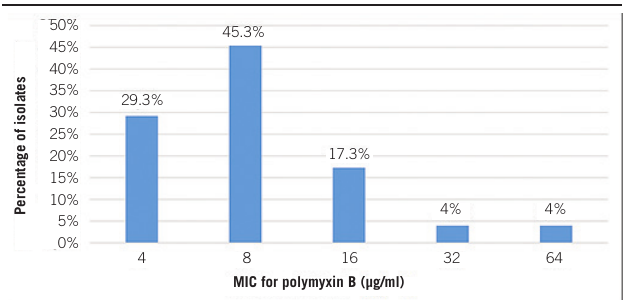
figurE 3 − Distribution of MIC in relation to polymyxin B-resistant isolates MIC: minimum inhibitory concentration.